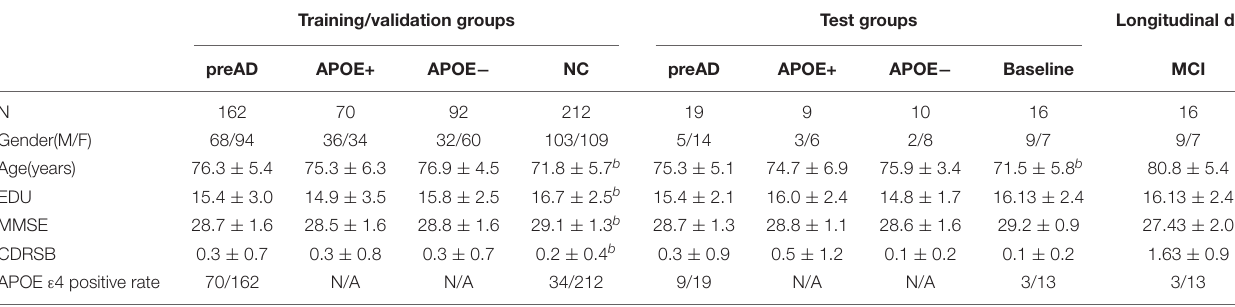
TABLE 1 | Demographic information for subjects.